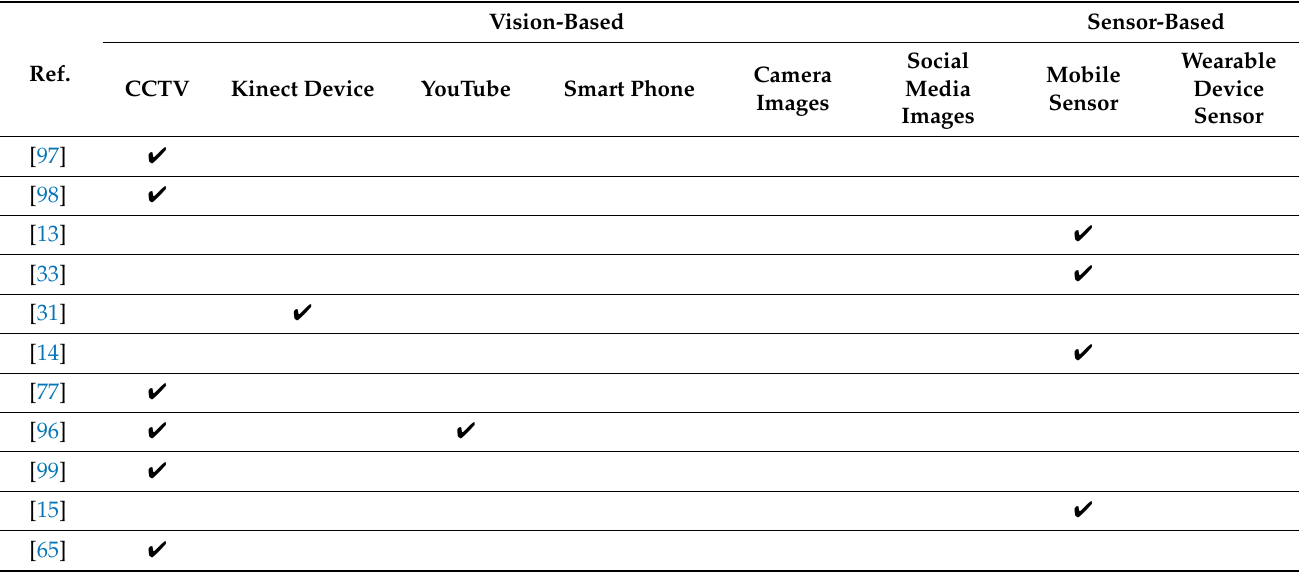
Figure 4. Frequency of data sources used by existing literature on HAR. Table 8. Vision-based and Sensor-based data sources used in the